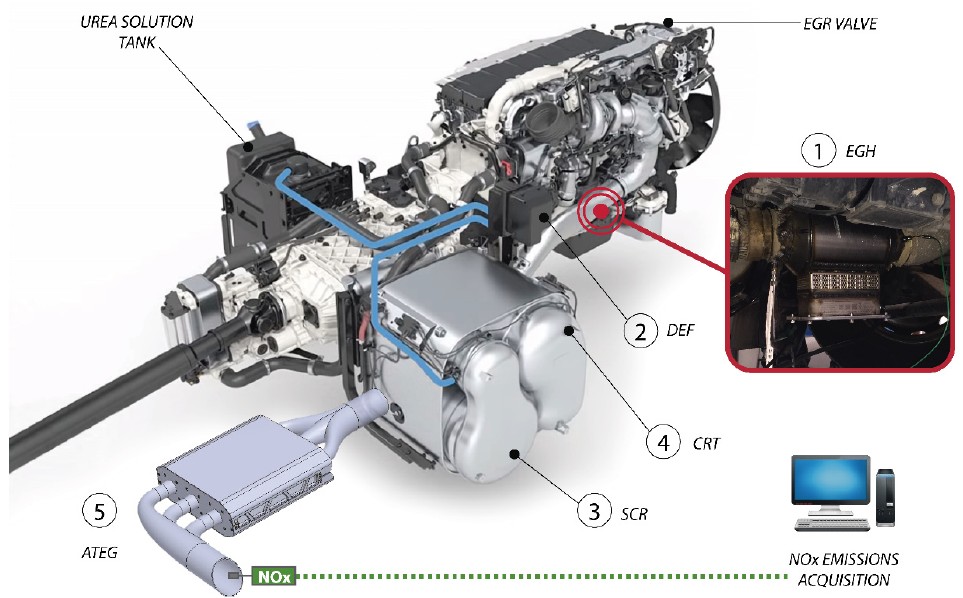
Figure 3. Scheme of the proposed system retrofitted in the tested vehicle with an ATEG representa- tion.